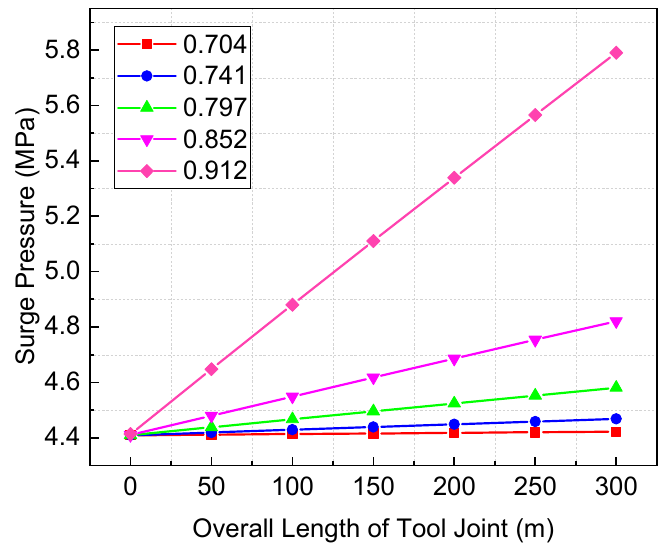
Figure 18. Surge pressure vs. overall length of tool joint.